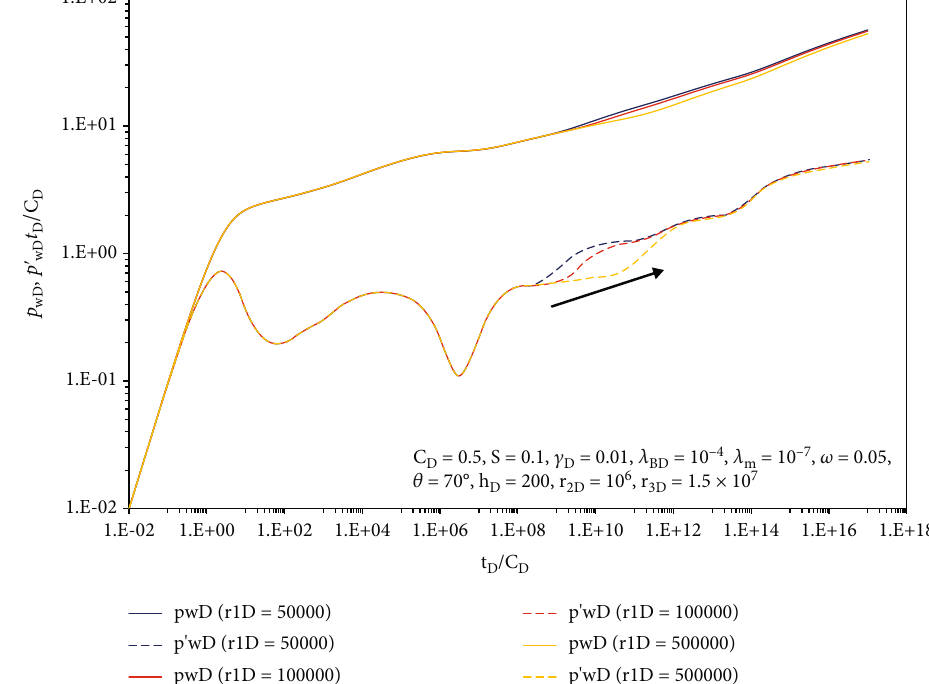
Figure 10: In fl uence of distance on pressure dynamic